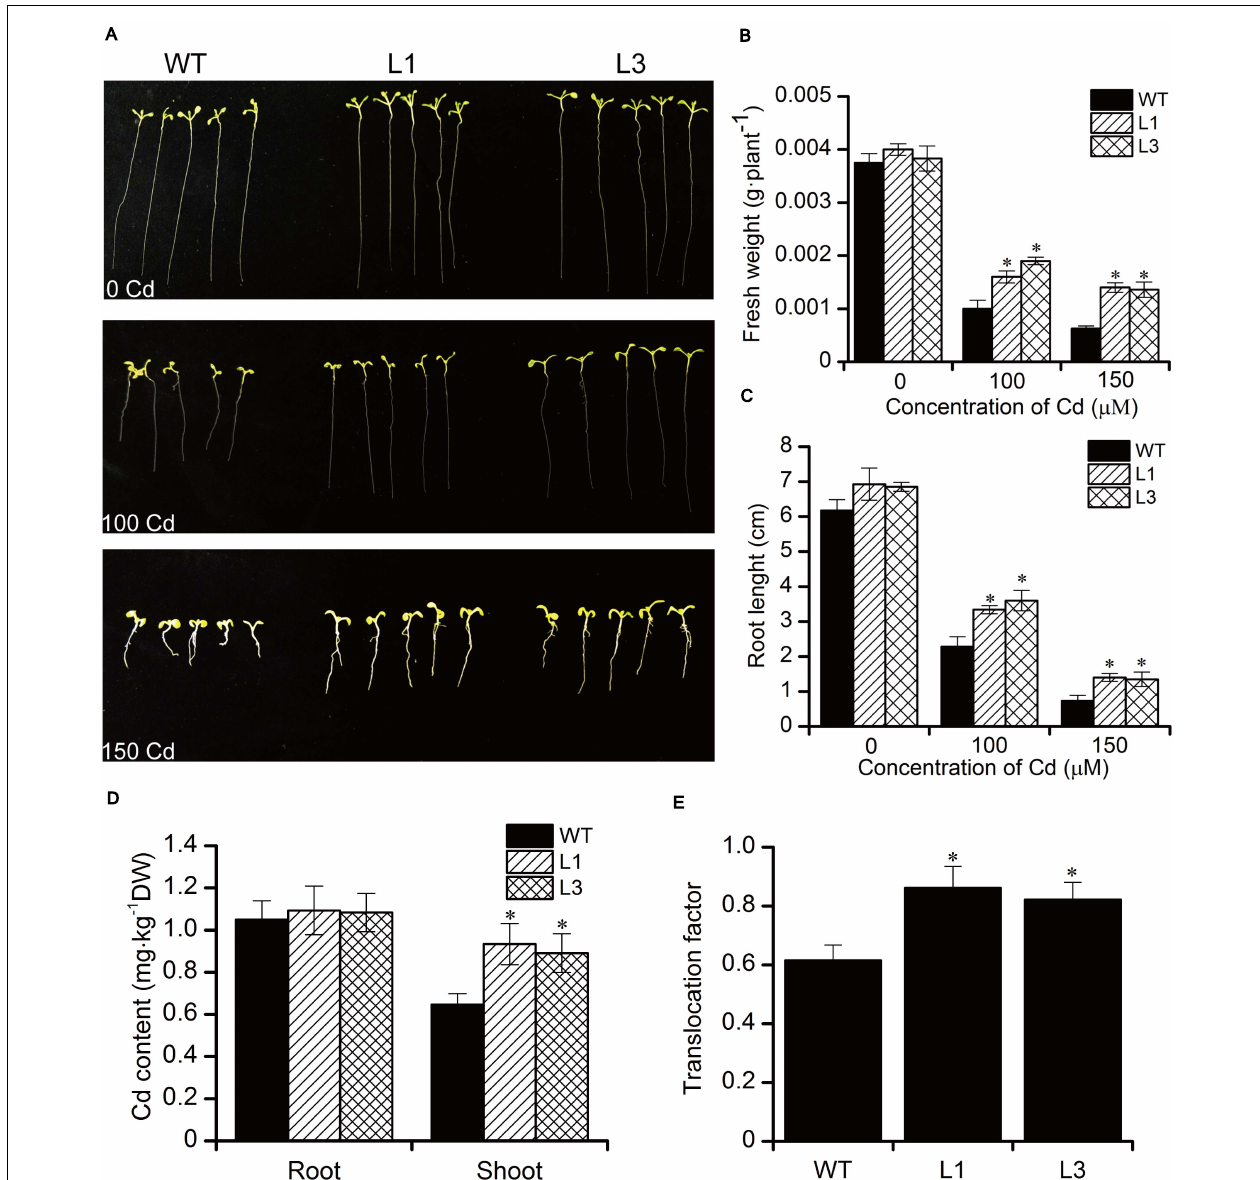
FIGURE 4 | Analysis of the response to Cd exposure in WT and BnPCS1 transgenic Arabidopsis plants. (A) Root lengths in Arabidopsis seedlings grown on 0.5 × MS medium containing 0, 100, or 150 µ MCd for 14 days. (B,C) Analysis of fresh weights and root lengths of Arabidopsis seedlings grown on 0.5 × MS medium containing 0, 100, or 150 µ M Cd for 14 days. (D) Cd content in roots and shoots of WT and transgenic Arabidopsis plants grown in vermiculite irrigated with 50 µ M Cd for 14 days; (E) Translocation factor (TF) of Cd in WT, L1 and L3. Data are presented as the means of three biological replicates with SE shown by vertical bars. Asterisks indicate significant differences ( p < 0.05) between the transgenic lines compared to